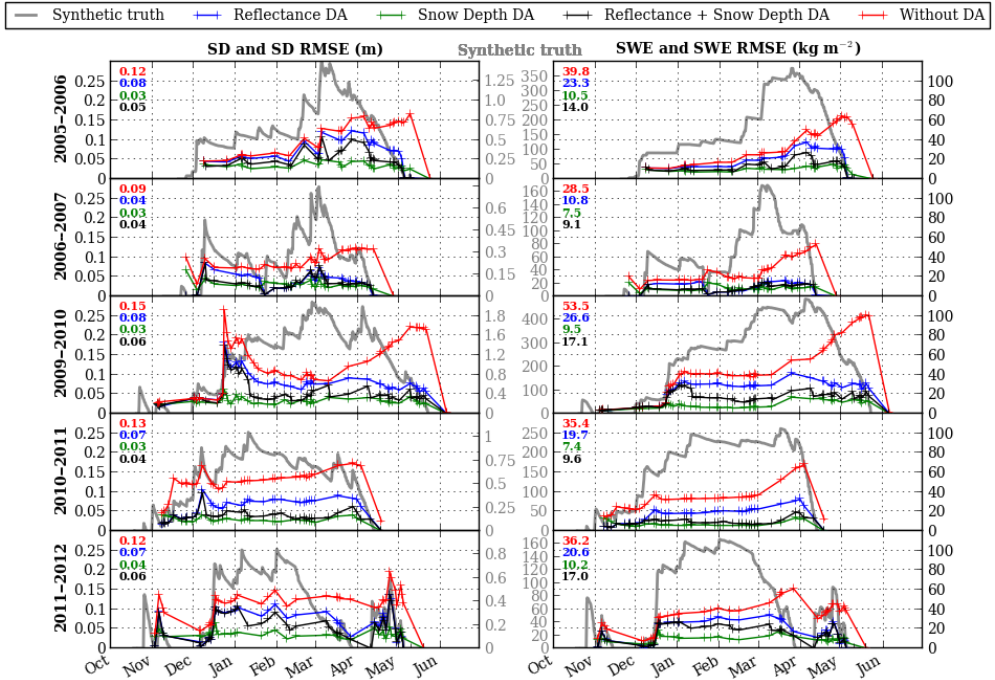
Figure 5. Time evolution of ensemble RMSEs on SD (left) and SWE (right) for the five seasons under study, for the run without assimilation (red lines), the baseline experiment (assimilating reflectances, blue lines), the experiment assimilating SD data (green lines) and the exper- iment assimilating combined reflectances and SD data (black lines). Crosses indicate analysis steps. Seasonal averages are displayed in the upper left corner of each graph. The model control simulation is represented by the grey lines, scaled by the “Synthetic truth” y